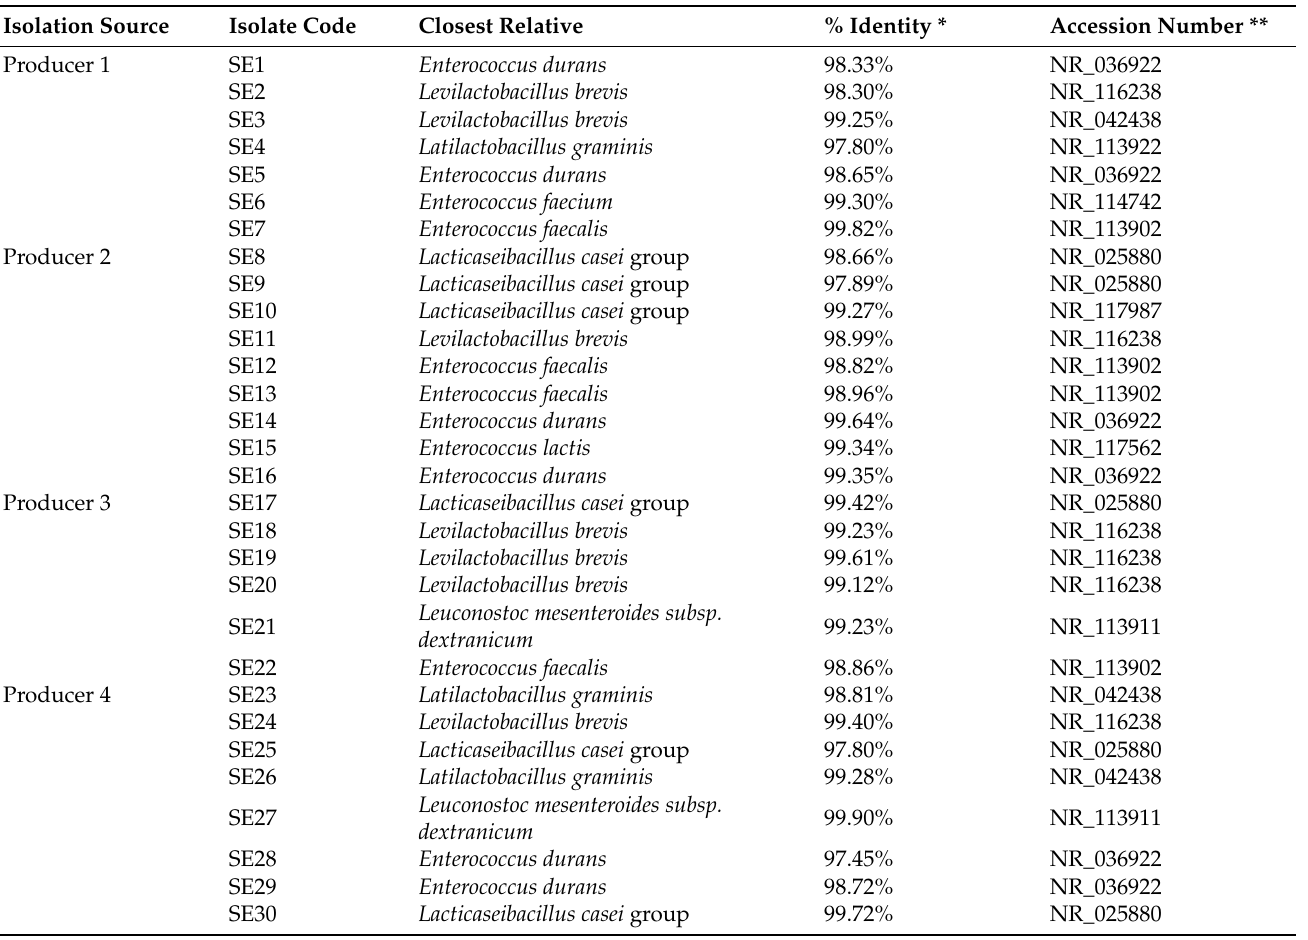
Table 5. Identification of non-starter lactic acid bacteria (NSLAB) isolated from Queijo Serra da Estrela PDO